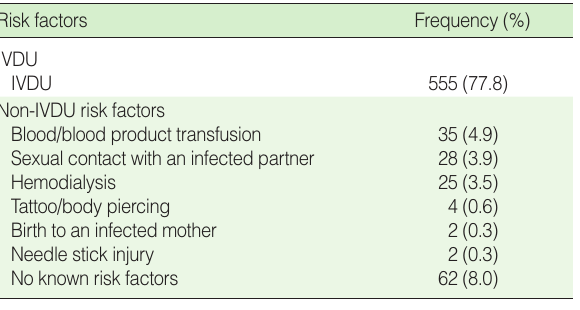
Table 2. Risk factors among patients diagnosed with hepatitis C in the Kota Setar district, Kedah, Malaysia from 2009 to 2013